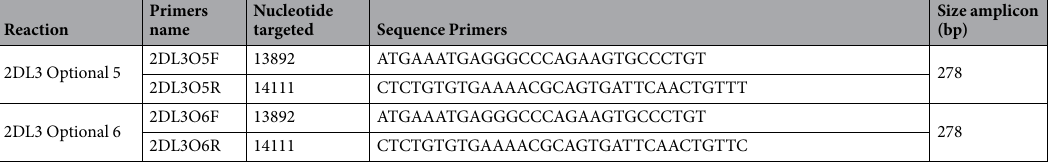
Table 1. KIR2DL PCR primers and target site